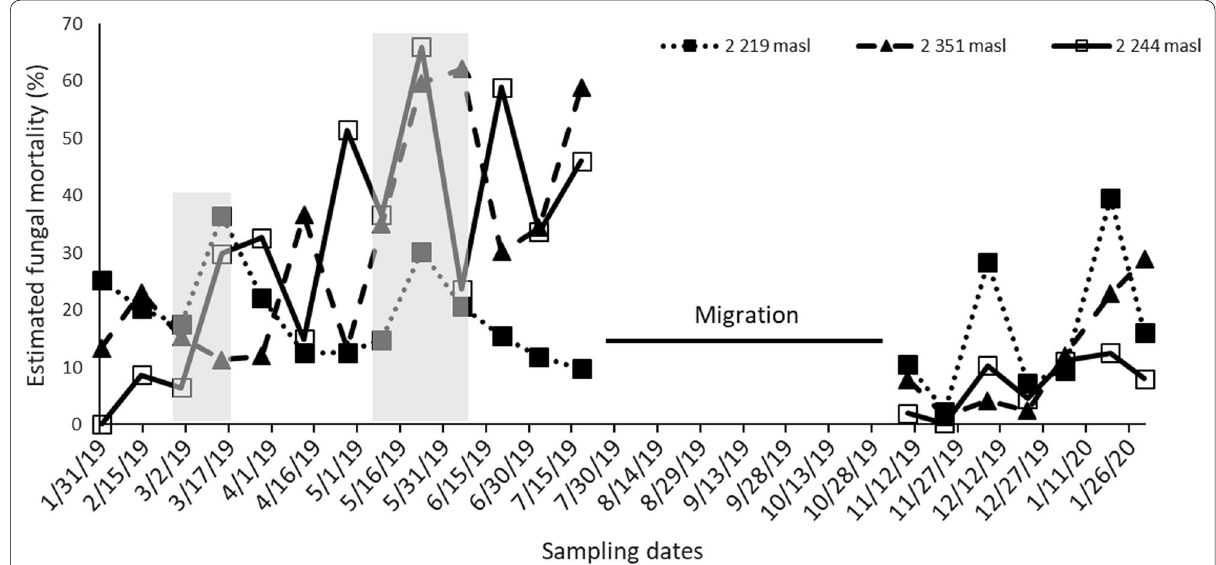
Fig. 6 Estimated mortality of Oebalus mexicana based on corpses with mycosis in the field hibernation sites in the Zináparo hill, Michoacán, Mexico. 2019–2020. Gray bar indicates swarm periods